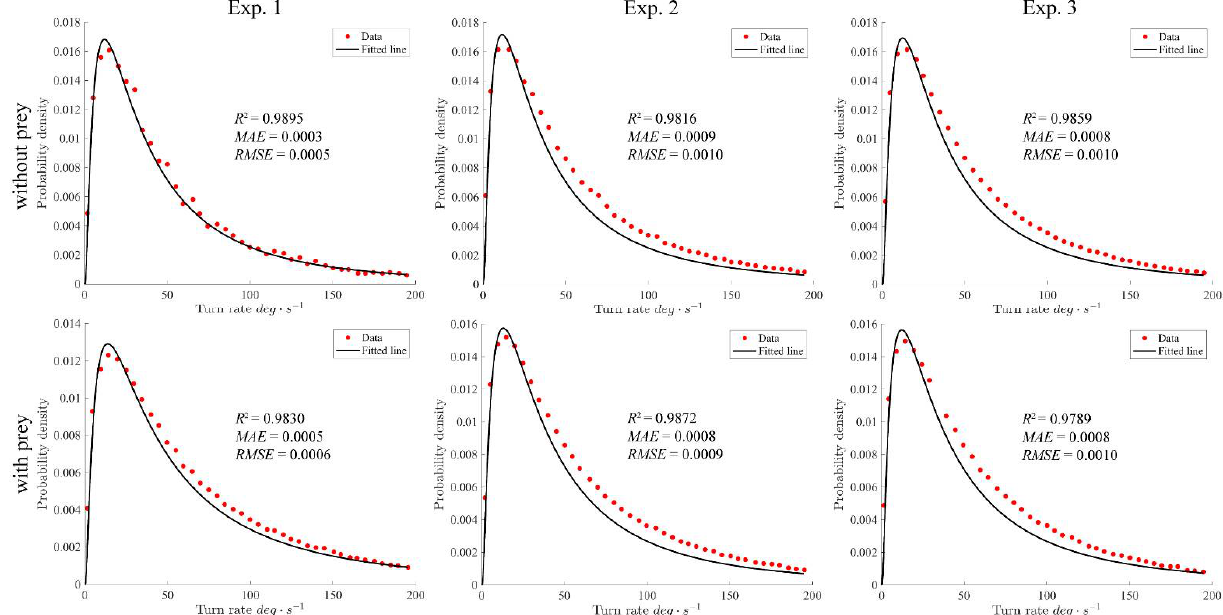
Figure 2. Fat tails in the frequency distributions of turning rates of O. marina before ( top ) and after ( bottom ) the introduction of a layer of I. galbana prey cells in three separate experiments (Exp. 1 with either direct addition of the prey alga; Exp. 2&3 with cell-free filtrate). The red dots: original data; black line: fitted curve using log-normal distribution formula.